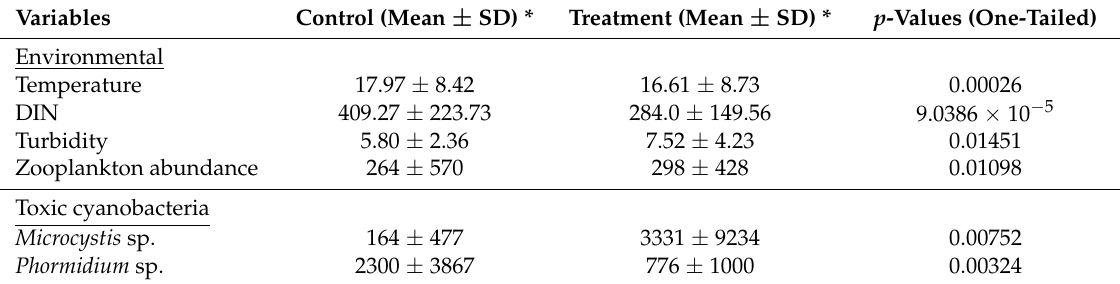
Table 3. Paired t -test results for the environmental variables and abundances (cell · mL − 1 ) of potentially toxic cyanobacteria collected from free-flowing (stations YA and YB; control) and impounded (stations YC and YD; treatment) sites. The data were transformed to log( x + 1) values prior to the statistical analysis.